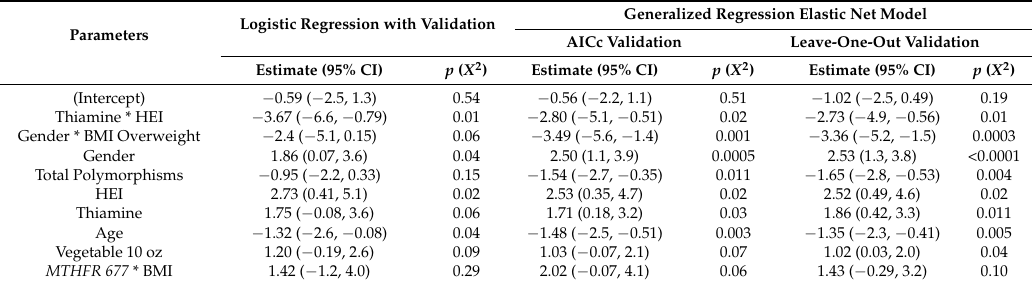
Table 5. Gene-diet interactions including MTHFR 677 on the predictors of colorectal cancer: baseline logistic regression model and generalized regression Elastic Net models.